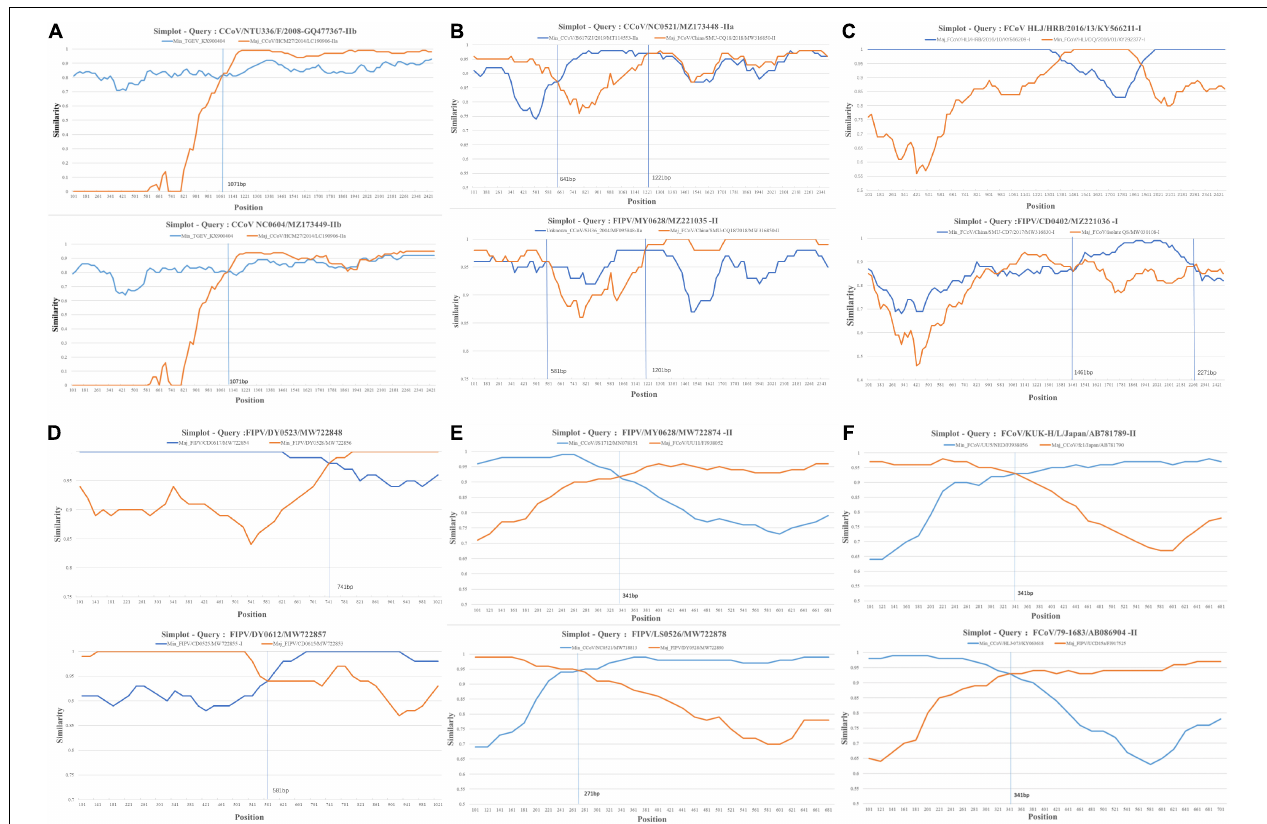
FIGURE 1 | Simplot recombination analysis of S1, N, and M genes in our samples. Each point is the percent genetic similarity within a 200-nt-wide sliding window centered on the position plotted with a step size of 20 nt. The blue line indicates the percentage of similarity between the secondary parent and the recombination sequence, and the red line shows the percentage of similarity between the primary parent and the recombination sequence. (A–C) Recombination events that occur within the S1 gene. (D) Recombination events that occur within the N gene. (E,F) Recombination events that occur within the M gene.